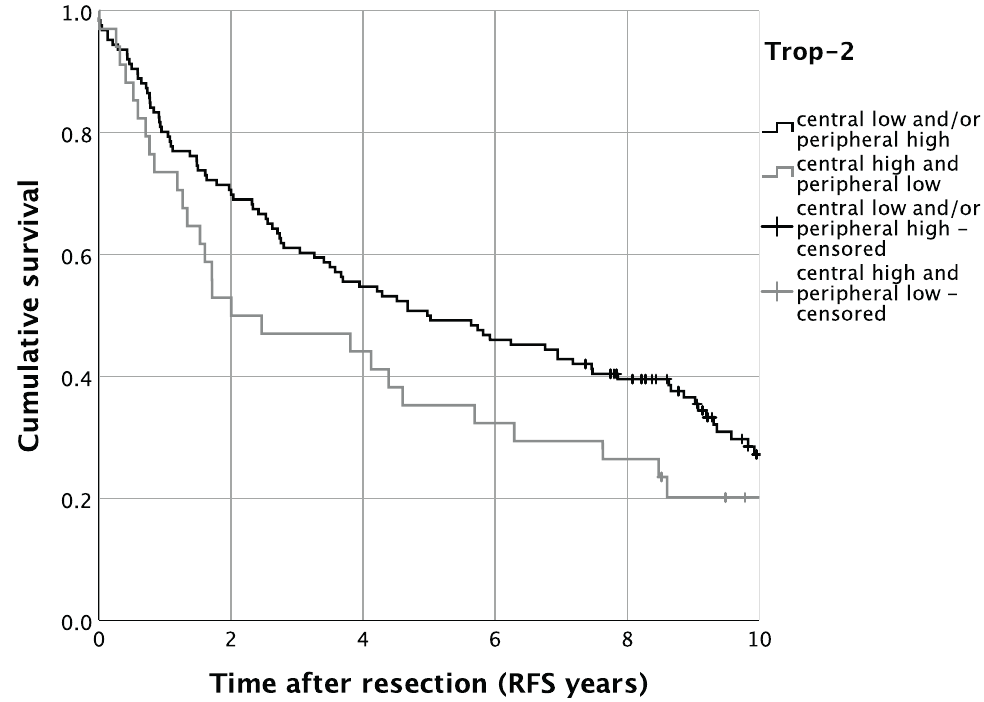
Figure 7. Kaplan–Meier analysis for varying Trop-2 H-scores for locoregional recurrence-free survival (RFS). n = 160. p =